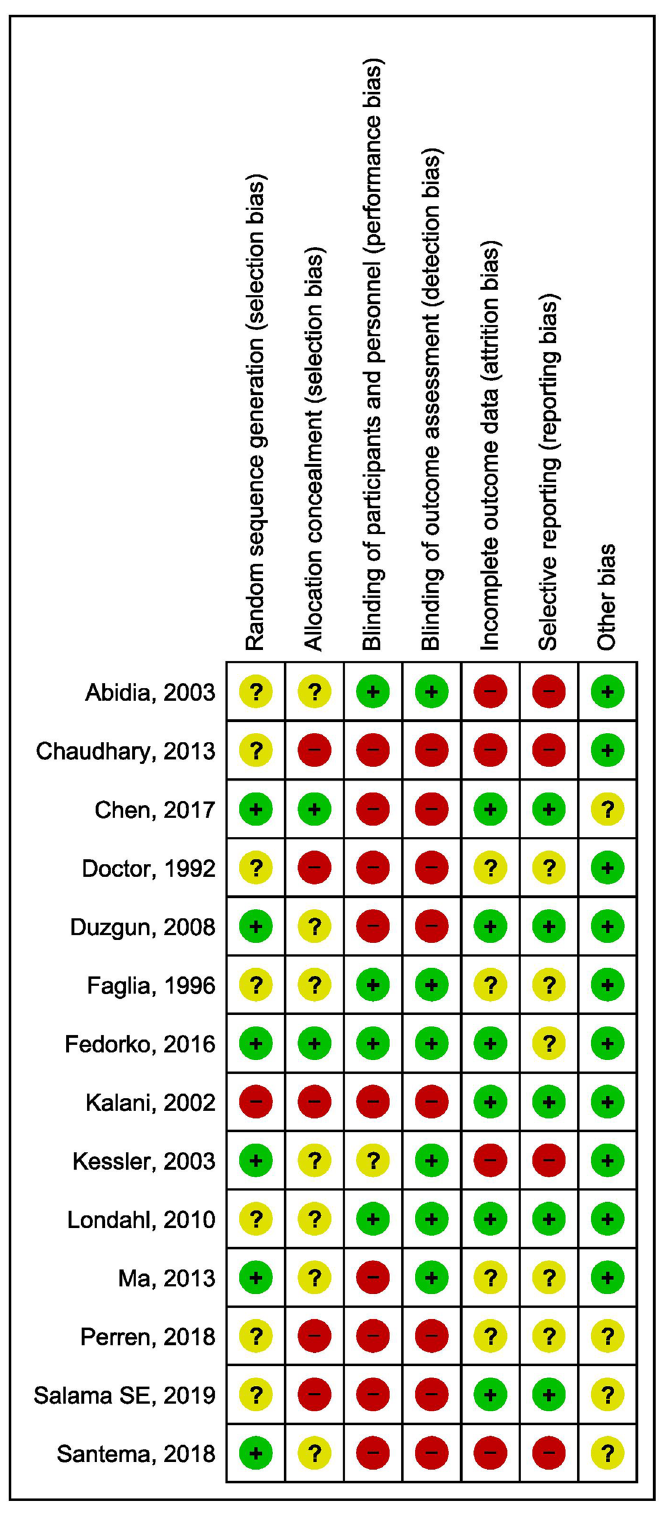
Figure 2. Risk of bias summary: review authors’ judgements about each risk of bias item for each included